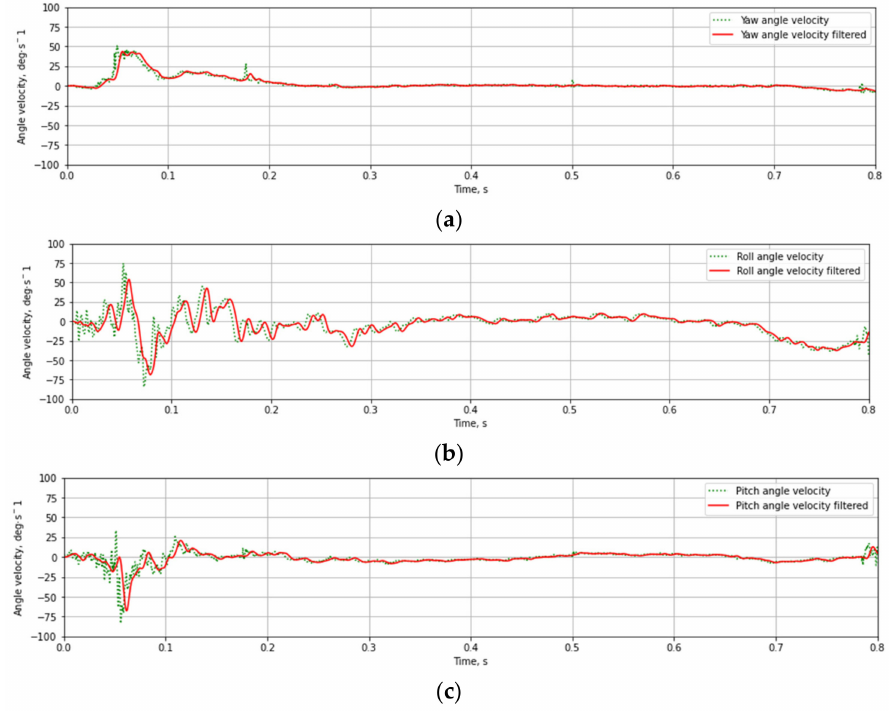
Figure 13. The vehicle acceleration as a result of an impact against T03 mast at 35 km/h: ( a ) rotation in OZ-axis, ( b ) rotation in OX-axis, ( c ) rotation in OY-axis. Based on the test data (Figures 12 and 13) and the Equations (1)–(3) time course